Question: Name the type of graph shown.
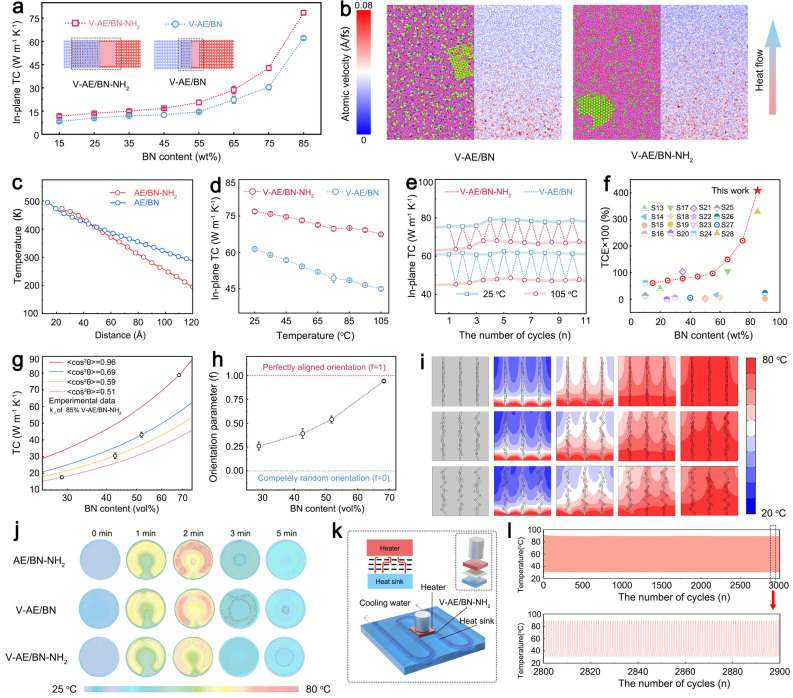
Answer: line